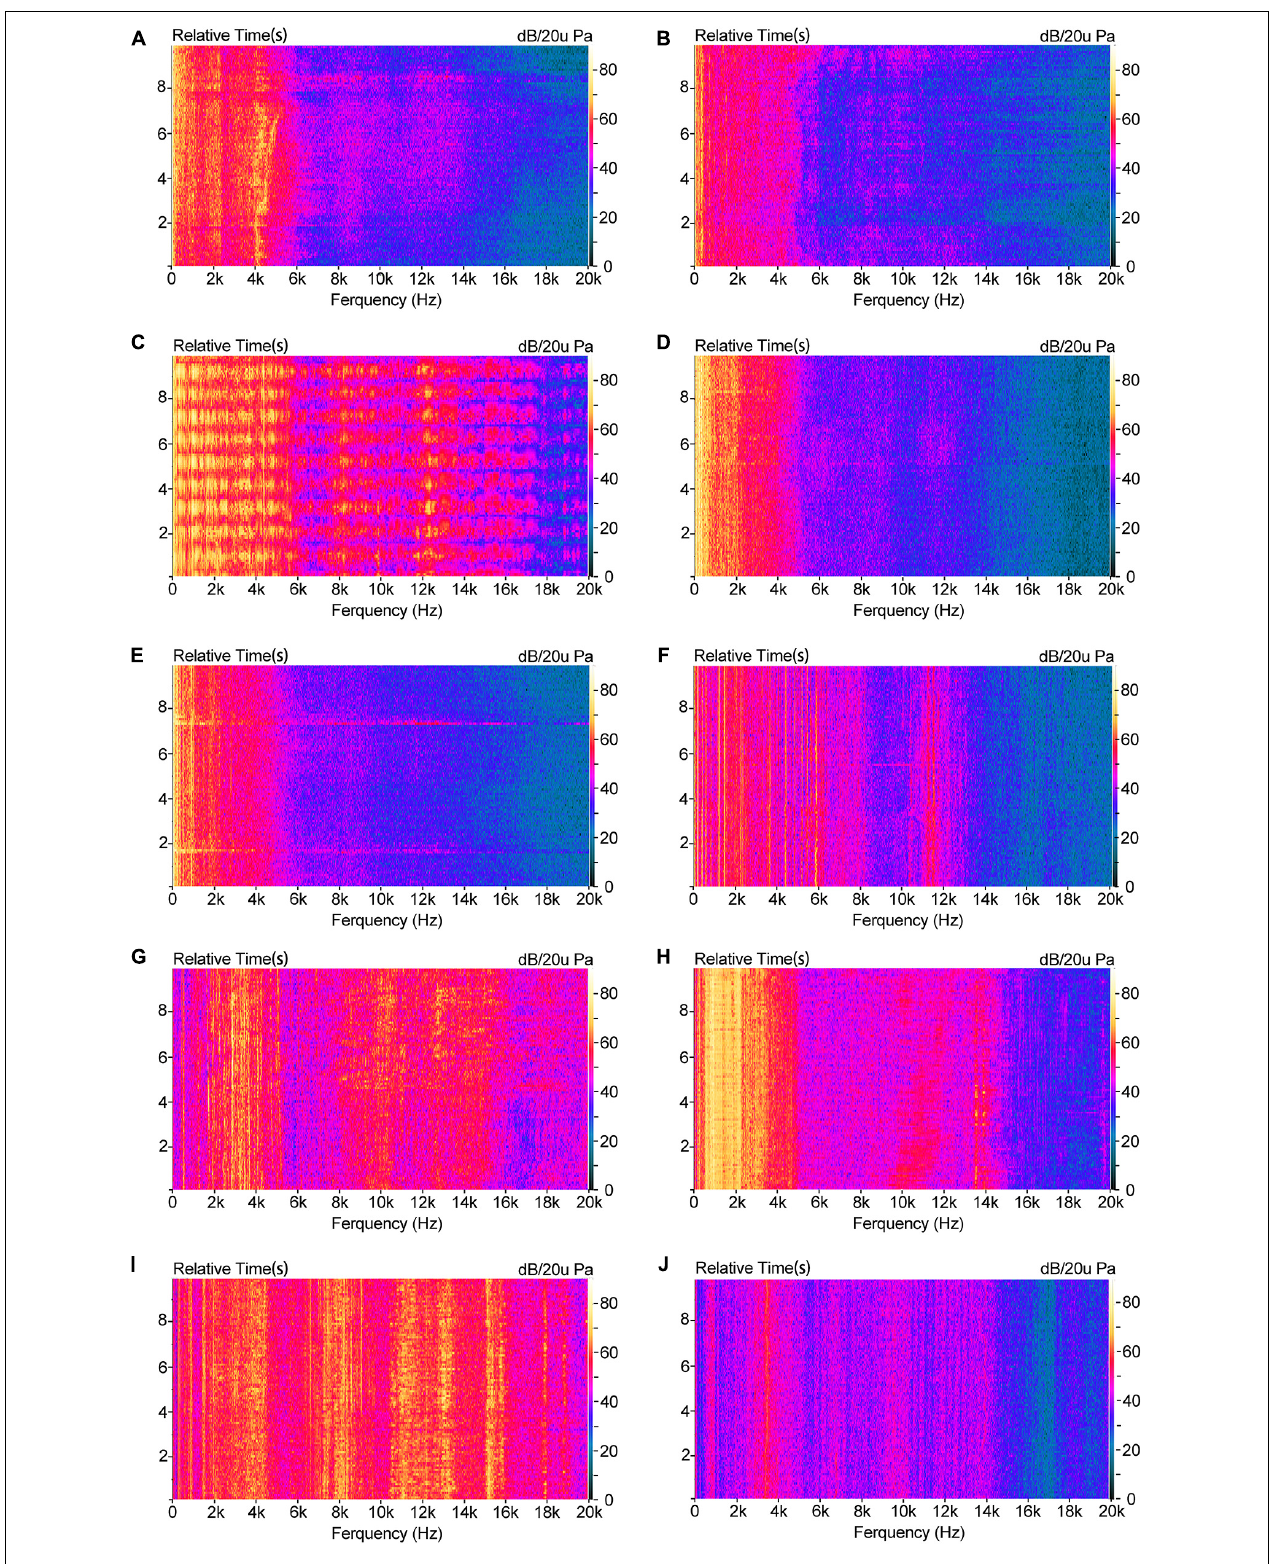
FIGURE 5 | FFT vs. Time: (A) Dump truck; (B) Excavator; (C) Breaker; (D) Loader; (E) Concrete pump; (F) Concrete vibrator; (G) Angle grinder; (H) Jackhammer; (I) Electric drill; (J) Electric screwdriver.